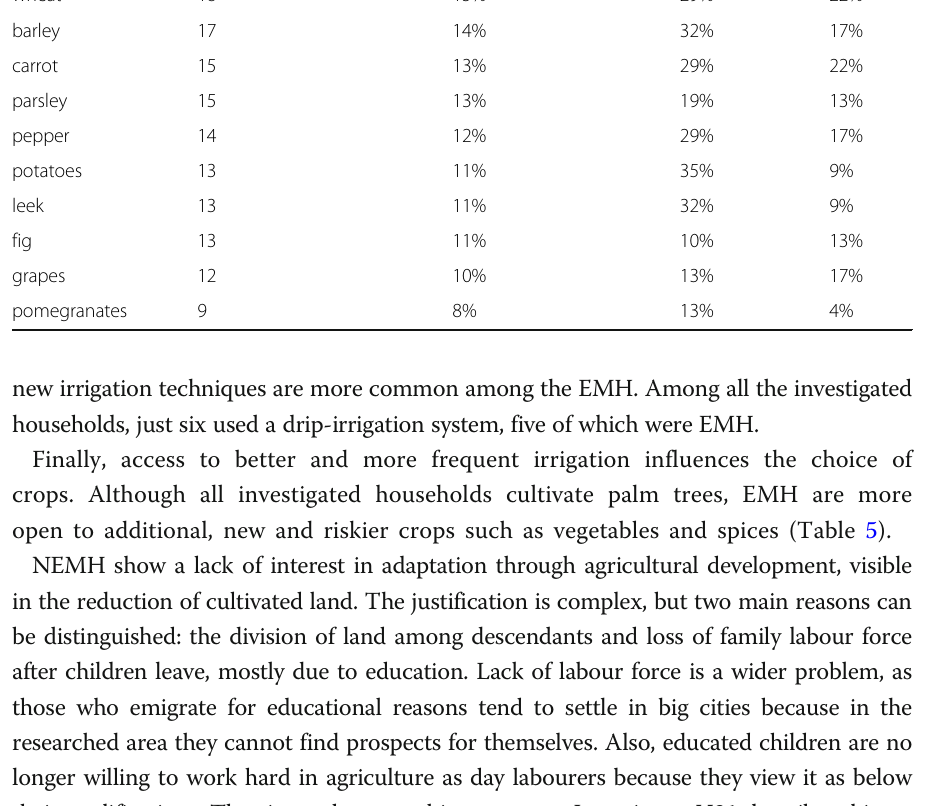
Table 5 Number of households cultivating crops other than the date palm Crop type Number of households % of all households % of EMH % of NMH wheat 18 15% 29% 22% barley 17 14% 32% 17% carrot 15 13% 29% 22% parsley 15 13% 19% 13% pepper 14 12% 29% 17% potatoes 13 11% 35% 9% leek 13 11% 32% 9% fig 13 11% 10% 13% grapes 12 10% 13% 17% pomegranates 9 8% 13%